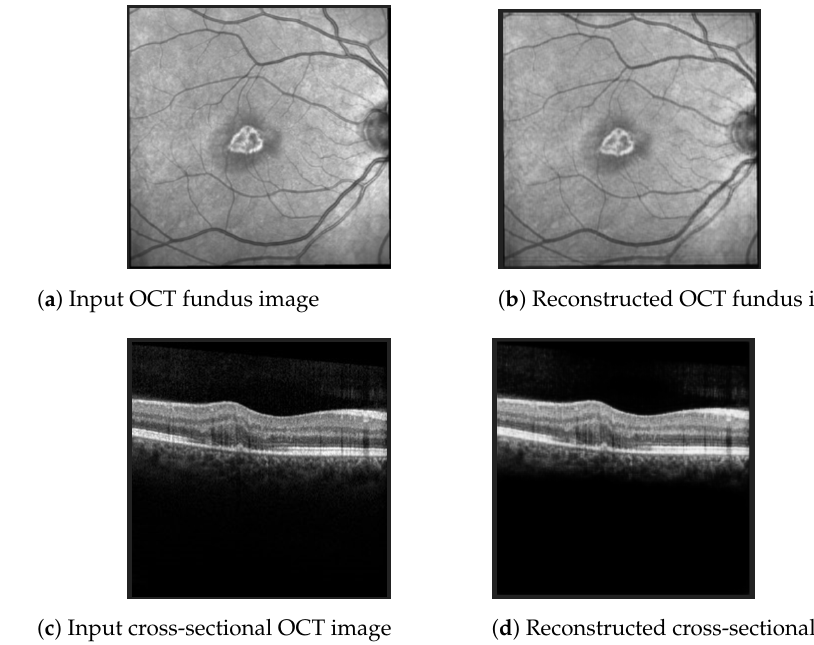
Figure 8. Examples of OCT scan reconstruction and noise filtering using the convolutional autoencoder.